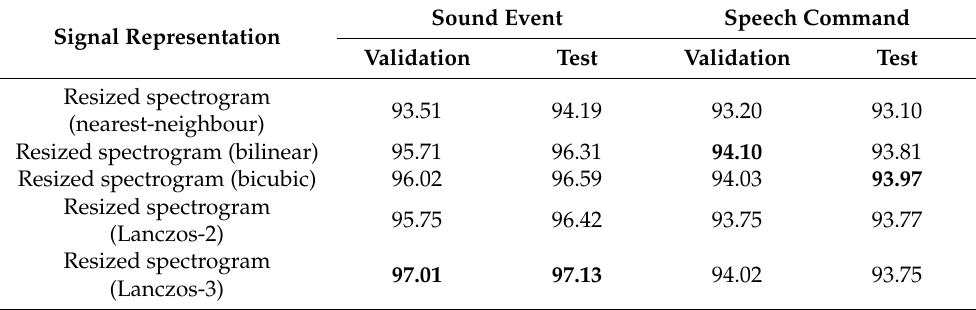
Table 4. Average classification accuracy (in %) of resized time-frequency image